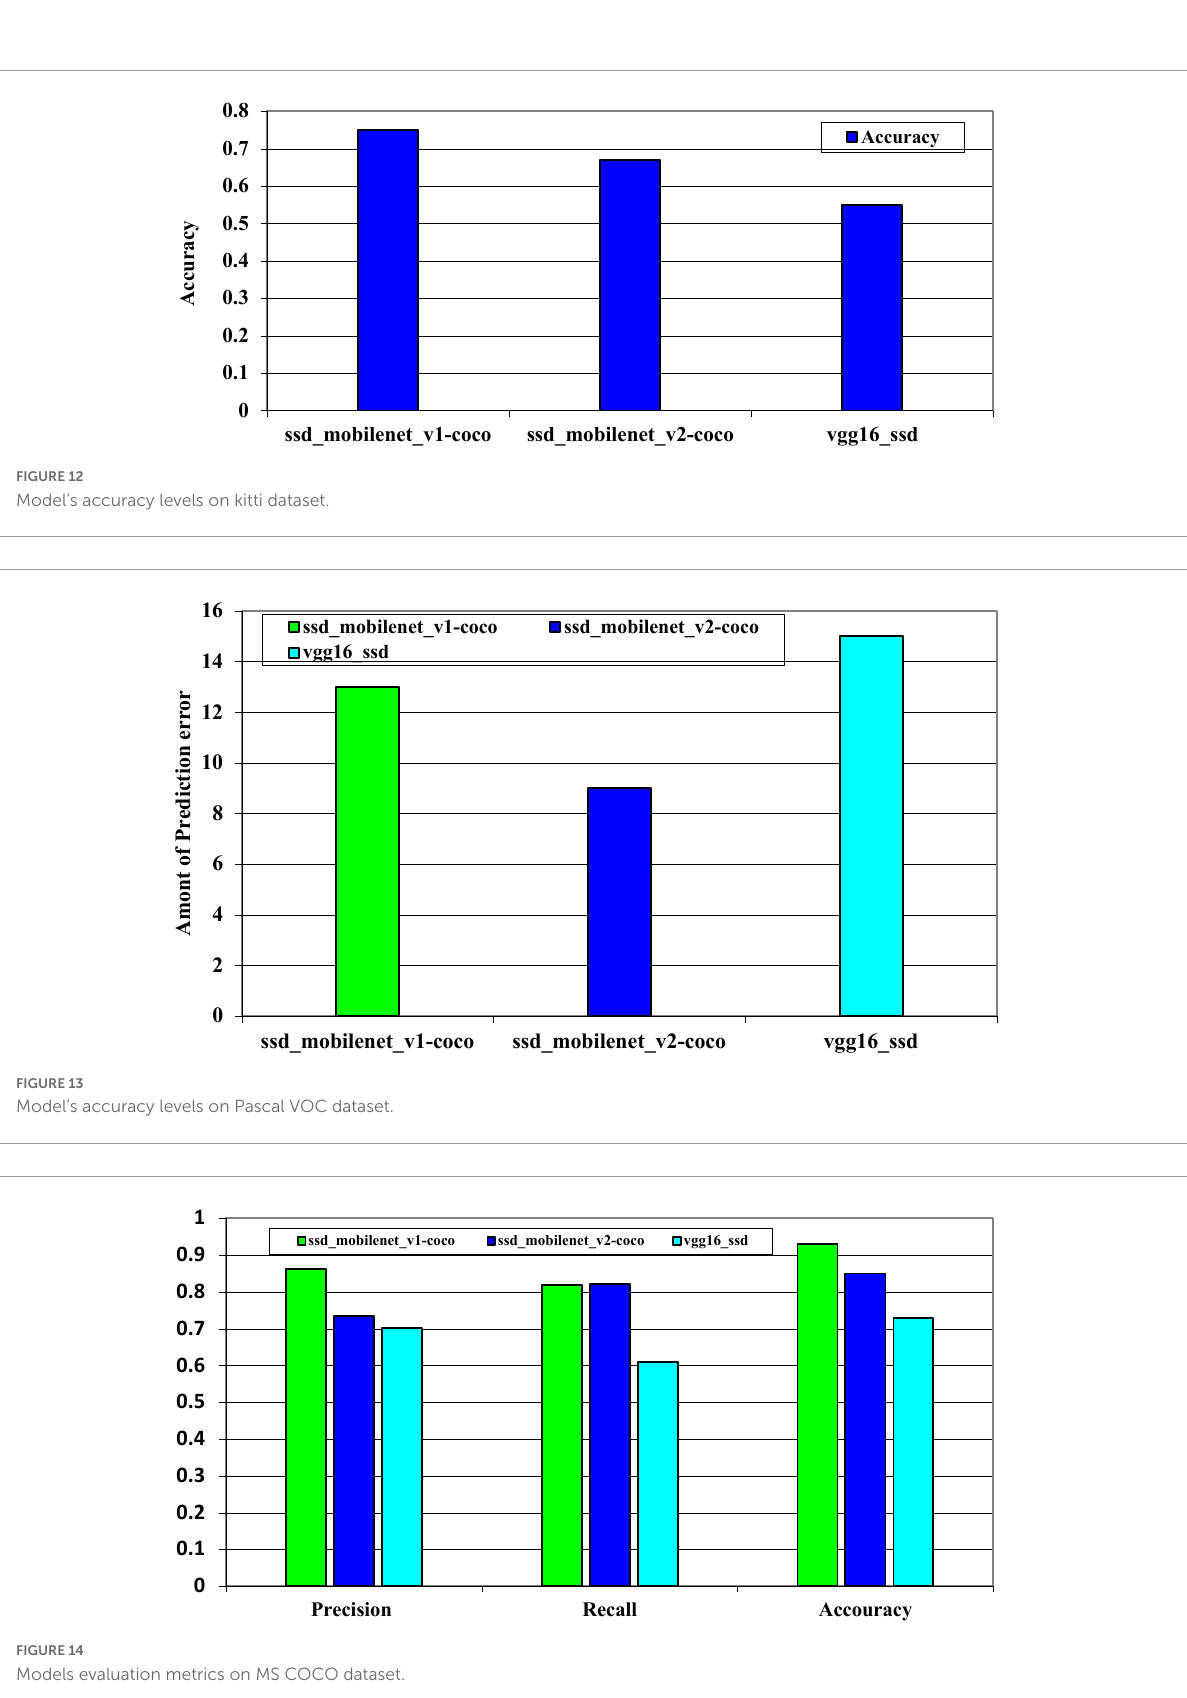
FIGURE14 Models evaluation metrics on MS COCO